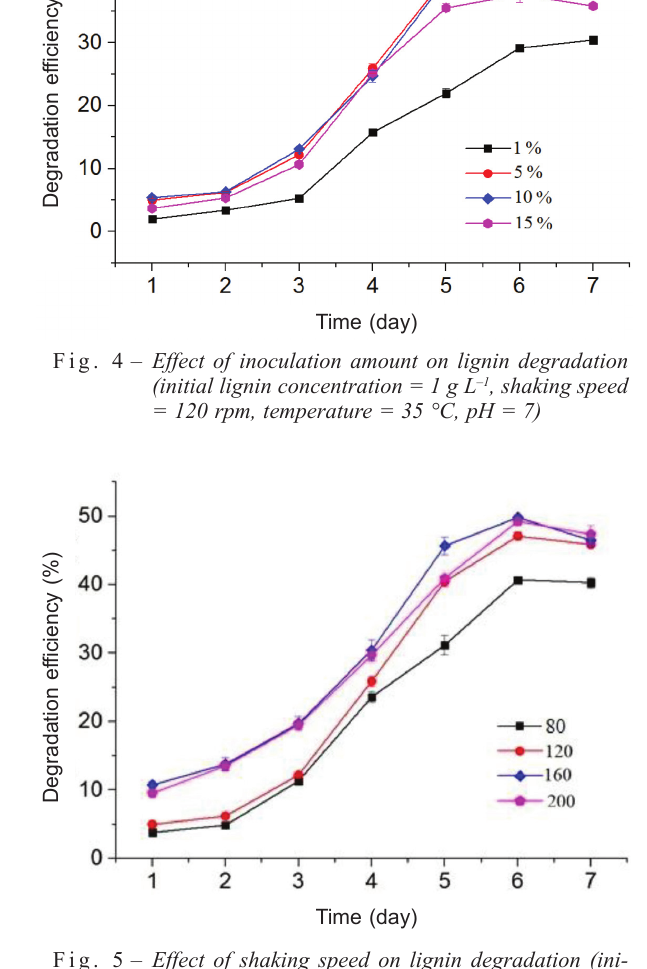
Fig. 5 – Effect of shaking speed on lignin degradation (ini­ tial lignin concentration = 1 g L –1 , inoculation amount = 5 %, temperature = 35 °C, pH =